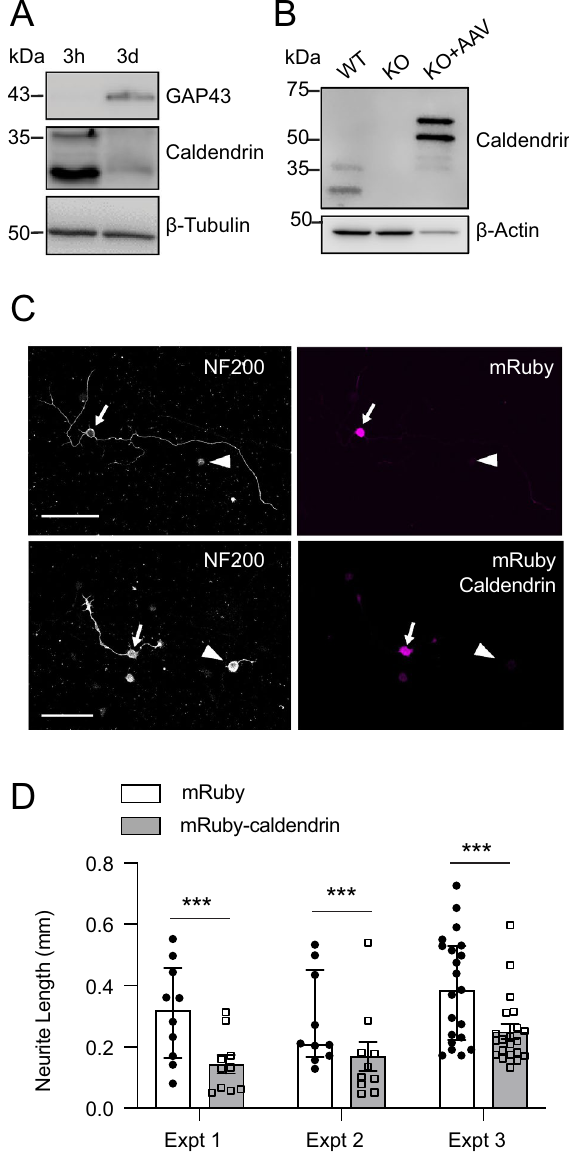
Figure 4. Reductions in caldendrin expression correlate with enhanced neurite growth in cultured DRGNs. DRGNs were plated in the in vitro axotomy assay for analysis of protein expression levels ( A , B ), or neurite growth ( C , D ). ( A ) Western blot showing decline in caldendrin protein levels when GAP43 expression is high. DRGN cultures from WT male mice were lysed 3 h or 3 d after plating and subject to electrophoresis. The western blot images correspond to 3 different gels in which lysates for the 2 time points were run in the same gel prior to probing with anti-caldendrin, anti- GAP43, or anti-β-Tubulin antibodies (Supp. Figure S1B). ( B ) Western blot of lysates from cultures exposed to AAV-mRuby (control) or AAV-mRuby-caldendrin for 3 d prior to harvest. Samples correspond to those from WT mice (lane 1) or caldendrin KO mice (lanes 2,3). Lane 3 represents caldendrin KO culture treated with AAV expressing mRuby-tagged caldendrin which is detected as two bands of higher molecular weight than the native caldendrin variants in WT lysates. Western blot images were cropped from a single blot that was probed sequentially with anti-caldendrin and anti-ß-actin antibodies. ( C ) Confocal micrographs of caldendrin KO cultures infected with AAV-mRuby (top) or AAV-mRuby- caldendrin (bottom) showing immunolabeling for NF200 (left) and mRuby (right). NF200-positive DRGNs with and without mRuby fluorescence are indicated by arrows and arrowheads, respectively. Scale bar, 100 µm. ( D ) Maximal neurite length per DRGN was measured in replated caldendrin KO cultures following AAV- mediated expression of mRuby (control) or mRuby-caldendrin. Data are shown for 3 independent experiments. Bars represent mean ± SEM. There was a significant effect of AAV treatment group on neurite length (F (1, 78) = 20.48, p < 0.0001, by 2-way ANOVA); *** p = 0.0003 by post-hoc Tukey’s